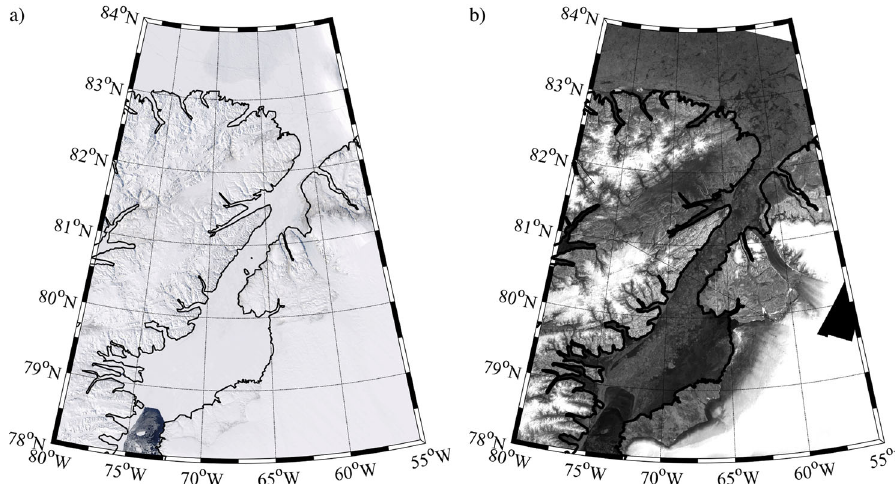
Fig. 4 Nares Strait sea ice conditions during May 2018. a MODIS true-color satellite and b Sentinel-1 SAR satellite imagery from May 2, 2018.